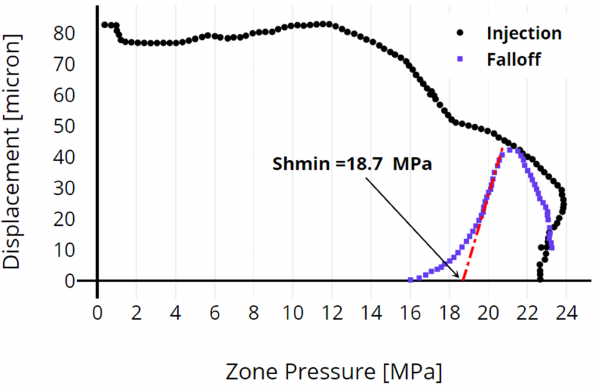
Figure 18. SIMFIP displacement versus zone pressure for cycle 2.1 (modified from